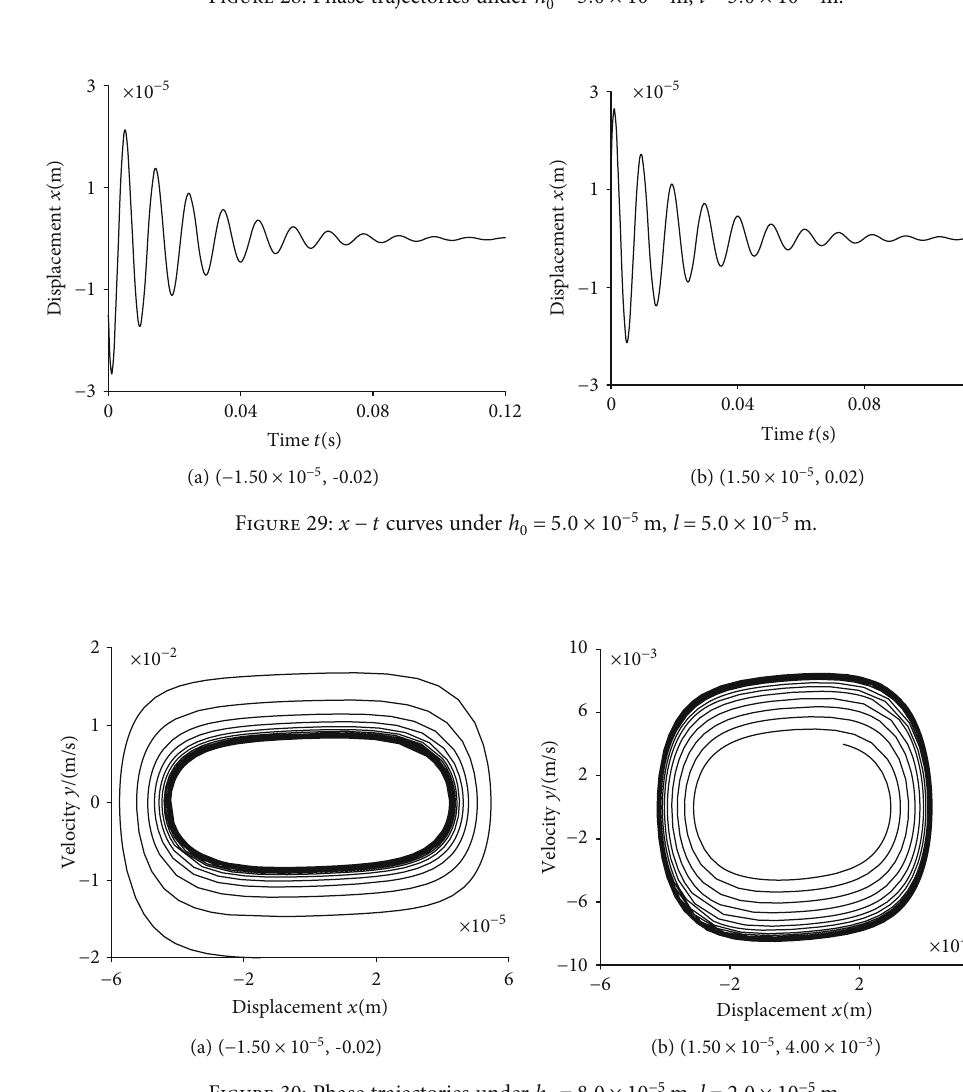
Figure 28: Phase trajectories under h